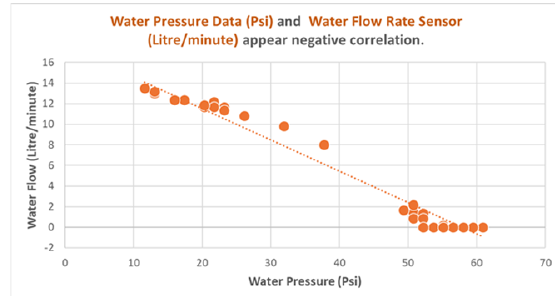
Figure 16. Data of water pressure and flow rate in three days.